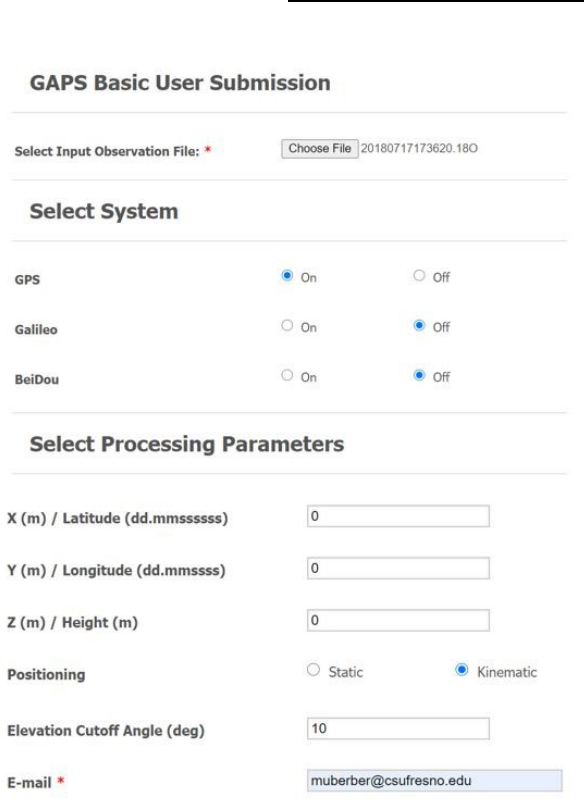
Fig. 7. Data processing parameters used in GAPS.